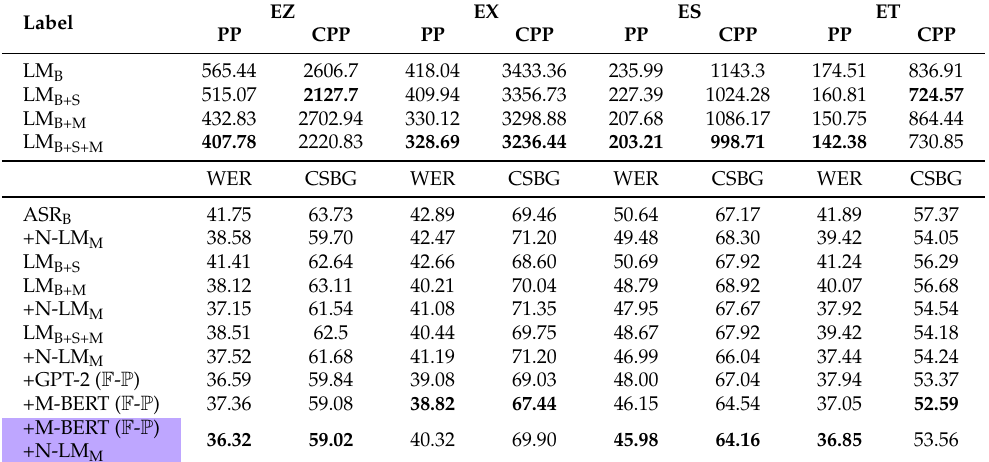
Table 7. Development set perplexity (PP) and code-switched perplexity (CPP) of the augmented n-gram language models (LM) for each of the four respective language pairs: English–isiZulu (EZ), English–isiXhosa (EX), English–Sesotho (ES), and English–Setswana (ET). The test set speech recognition error rates (WER) and code switched bigram error rates (CSBG) when utilising the augmented n-gram language models and additional rescoring by the pretrained neural language model (+N-LM) or multilingual language model (+GPT-2 ( F - P ) or +M-BERT ( F - P )) are also